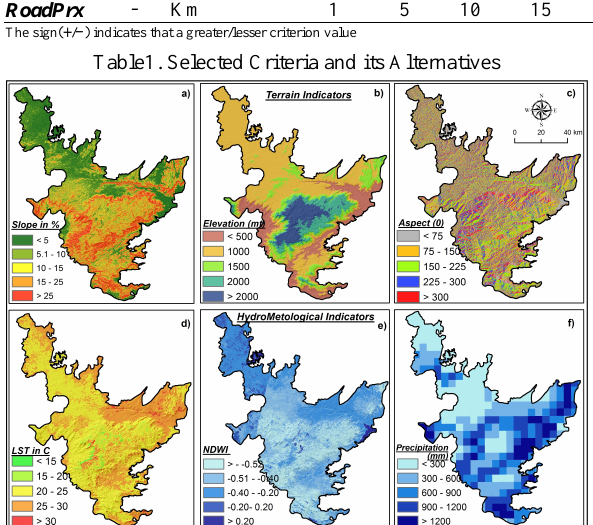
Figure 2. Thematic layers of TI and